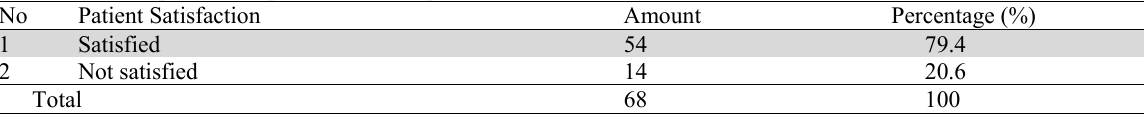
Distribution of respondent responses based on patient satisfaction